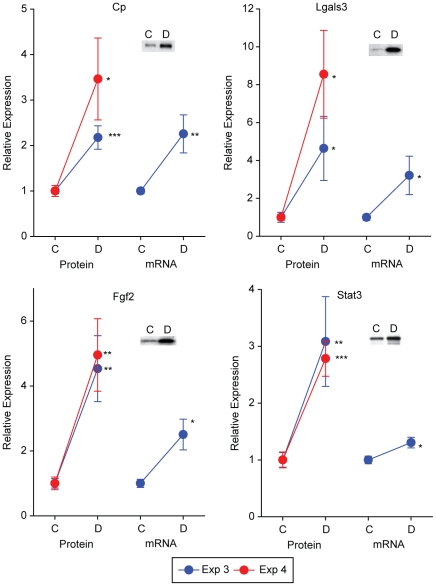
Confirmation of discovery findings in independent animal sets.Targets identified in the proteomic and transcriptomic analyses were confirmed at the level of protein expression by immunoblotting in two independent animal sets (Experiments 3 & 4). mRNA expression was also examined in samples from Experiment 3 by qPCR. Elevated levels of retinal Ceruloplasmin (Cp), Galectin 3 (Lgals3), fibroblast growth factor 2 (Fgf2), and signal transducer and activator of transcription 3 (Stat3) protein were confirmed in both sets of animals. For these proteins the increase in protein expression was mirrored by increased mRNA expression. C = Control, D = Diabetic, * p<0.05, ** p<0.01, *** p<0.001, two-tailed t-test.